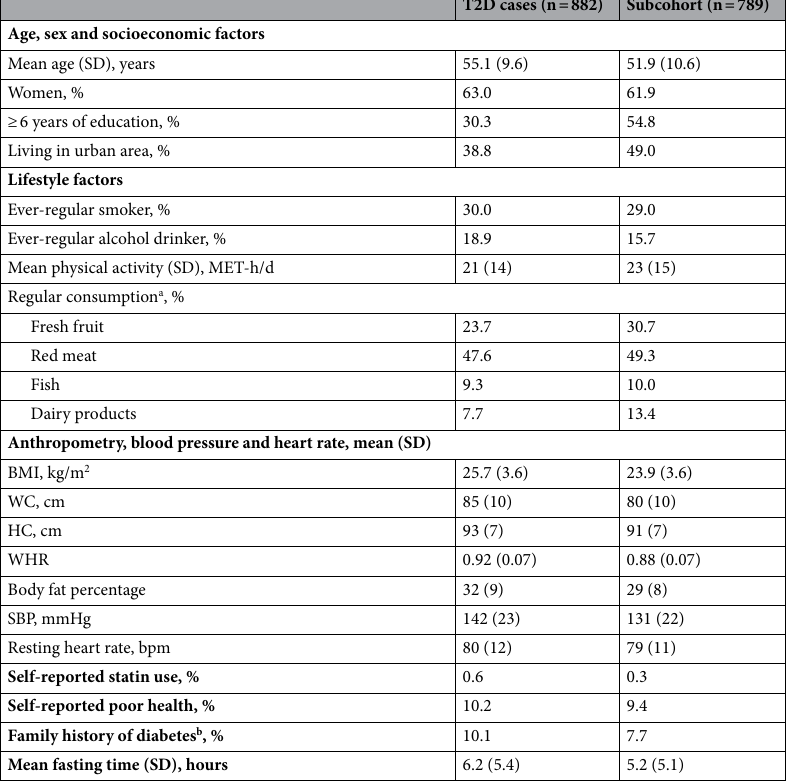
Table 1. Baseline characteristics of T2D cases and subcohort participants. BMI body mass index, HC hip circumference, MET-h/d metabolic equivalent of task hours per day, SBP systolic blood pressure, T2D type 2 diabetes, WC waist circumference, WHR waist-to-hip ratio. a Consumption on at least 4–6 days per week. b History of diabetes among first-degree